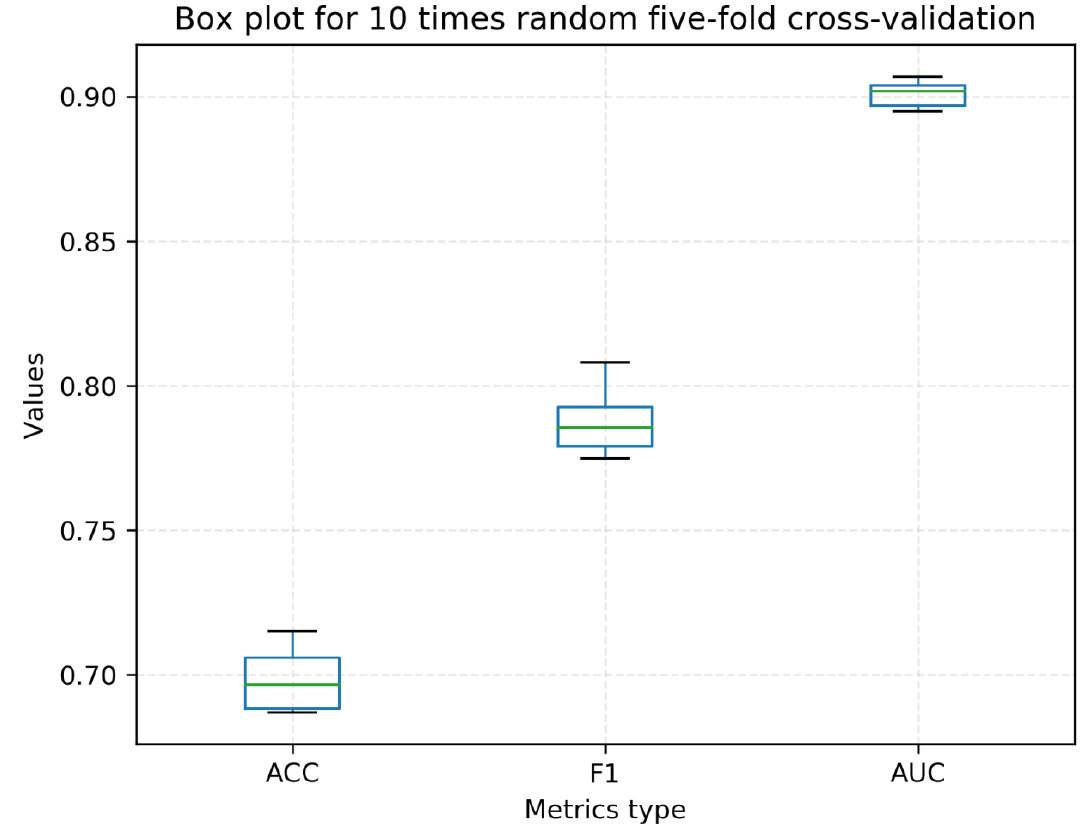
Figure 3. Box plot of LightGBM-Lncloc with 10 random 5-fold cross-validations.